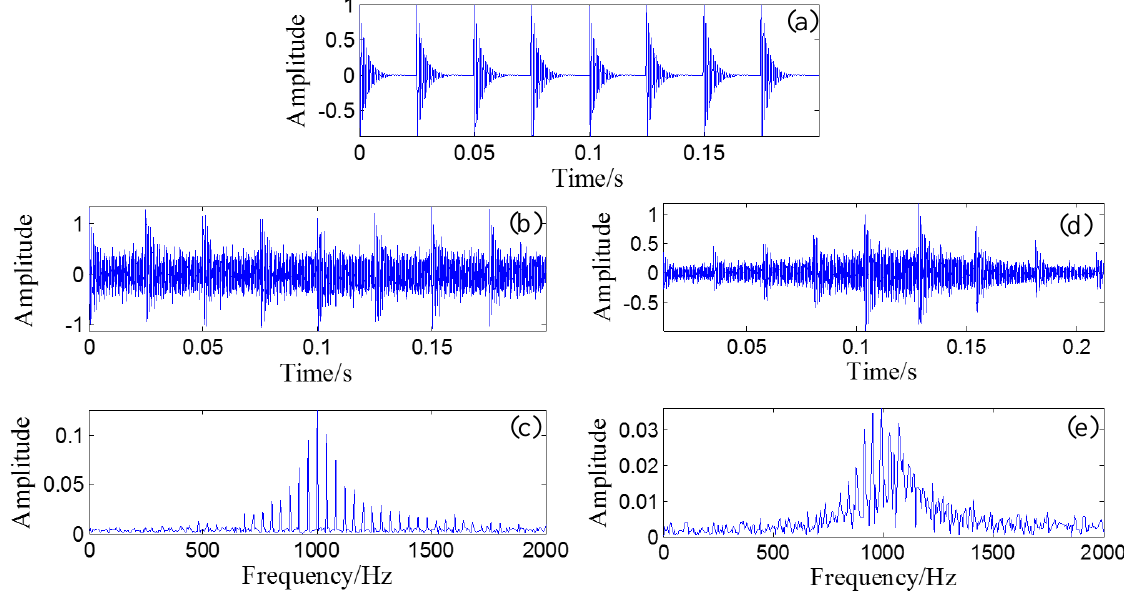
Figure 10. ( a ) Waveform of the simulated bearing signal without noise; ( b ) Waveform of the simulated bearing signal with noise and ( c ) its FFT spectrum; ( d ) Waveform of the simulated Doppler-shifted bearing signal with noise and ( e ) its FFT